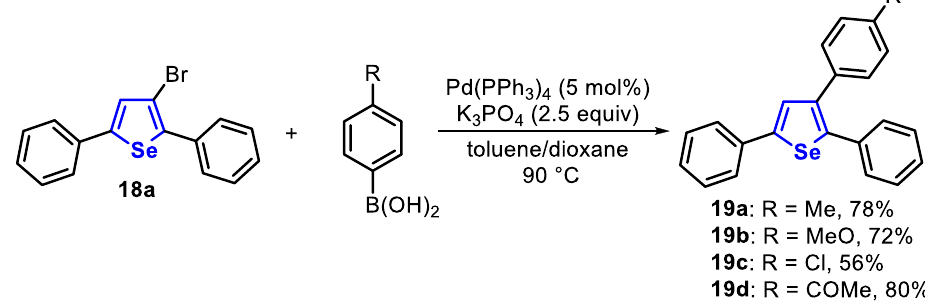
Scheme 17. Synthesis of 2,3,5-triarylselenophenes by Pd-catalyzed Suzuki cross-coupling